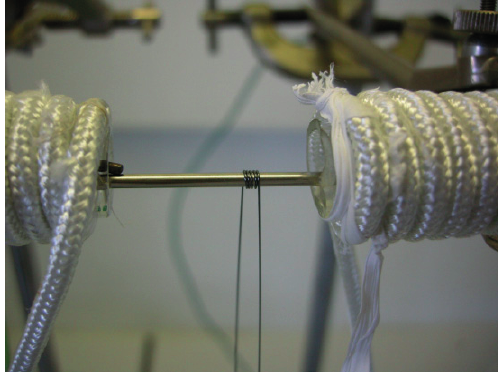
Figure 1. Photograph of the shaping set-up with the loop-shaped optical fiber. The steel mandrel is heated above the Tg of the glass thanks to the resistive elements on both sides.